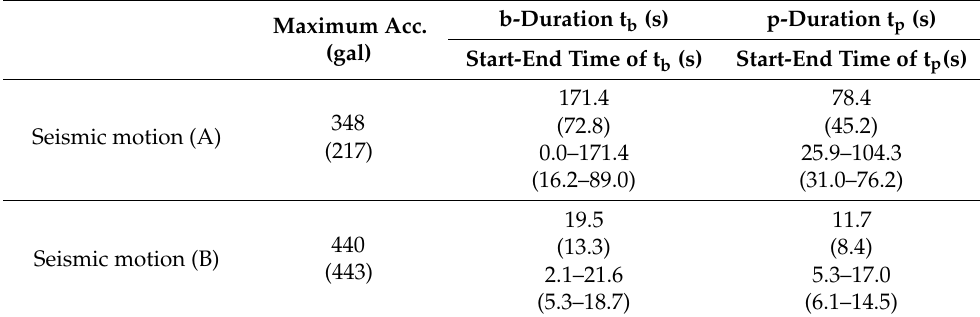
Table 4. Duration of seismic motion (A) and (B). The upper part of each item in the table shows the value of the adjusted wave, and the lower part (in parentheses) shows the value of the original seismic wave.